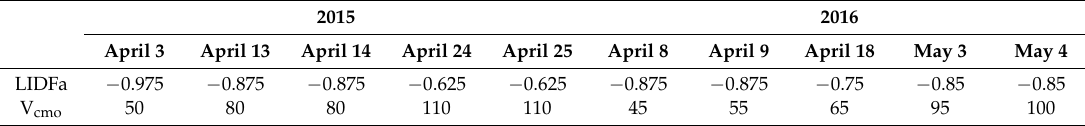
Table 3. The retrieved daily LIDFa and V cmo values (unit: µ mol m − 2 s − 1 ) on ten fieldwork days in